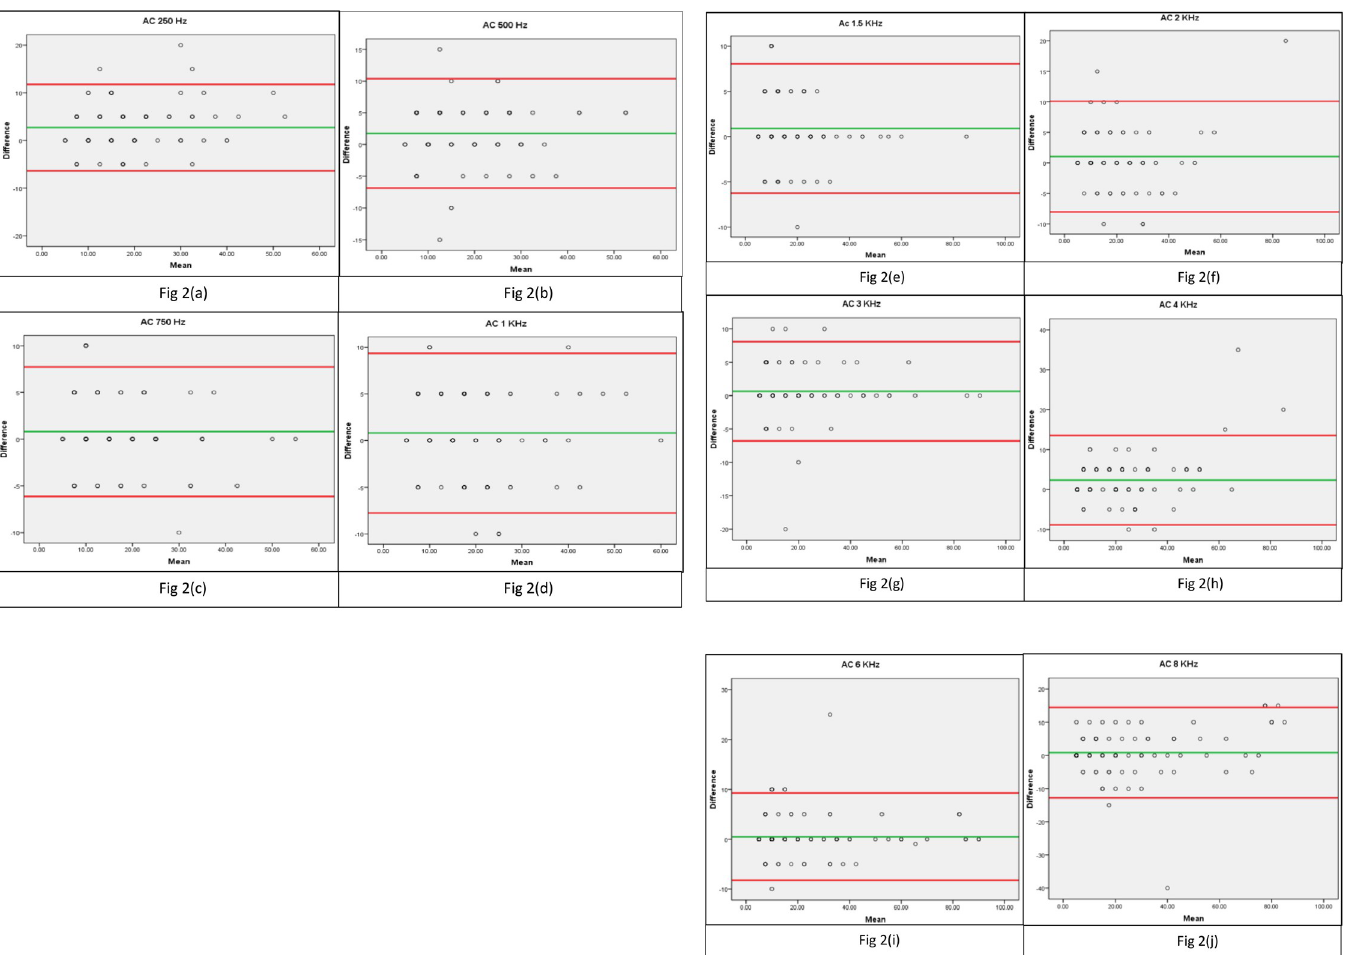
Fig 2. (A-K): Bland Altman plots showing difference against mean for air conduction thresholds across frequencies between gold standard and HEARZAP audiometry.